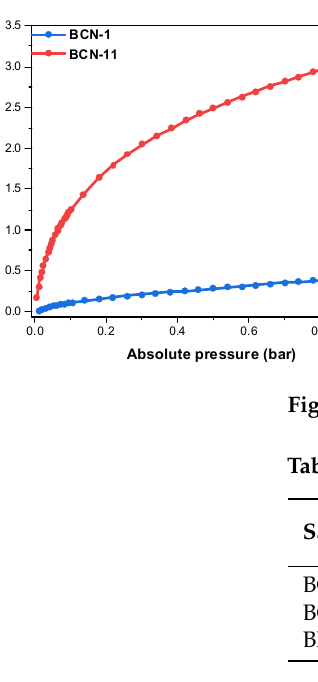
Table 3. CO 2 uptake performances of the studied materials at 1 bar.